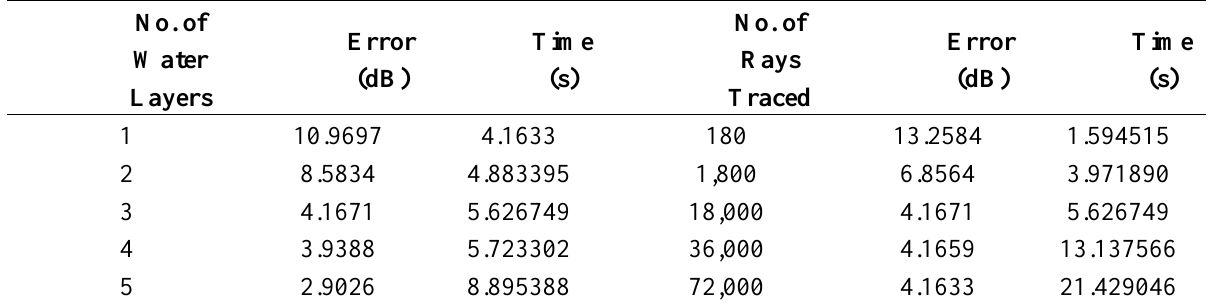
Table 1. Impact of parameters on both accuracy and computation